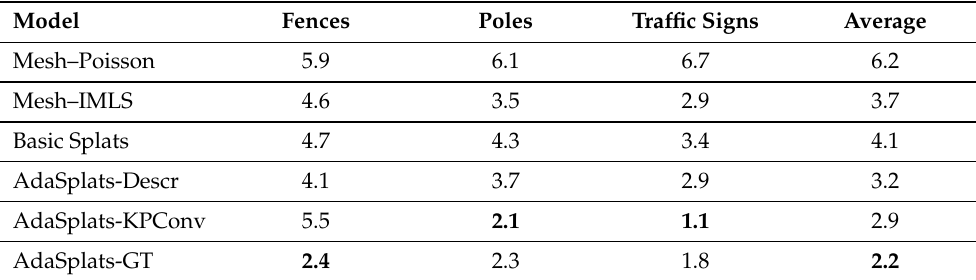
Table 3. Cloud-to-Cloud distance (in cm) computed on PC3D-Paris for points that belong to classes of thin structures between the simulated and original point cloud. The AdaSplats methods include resampling.